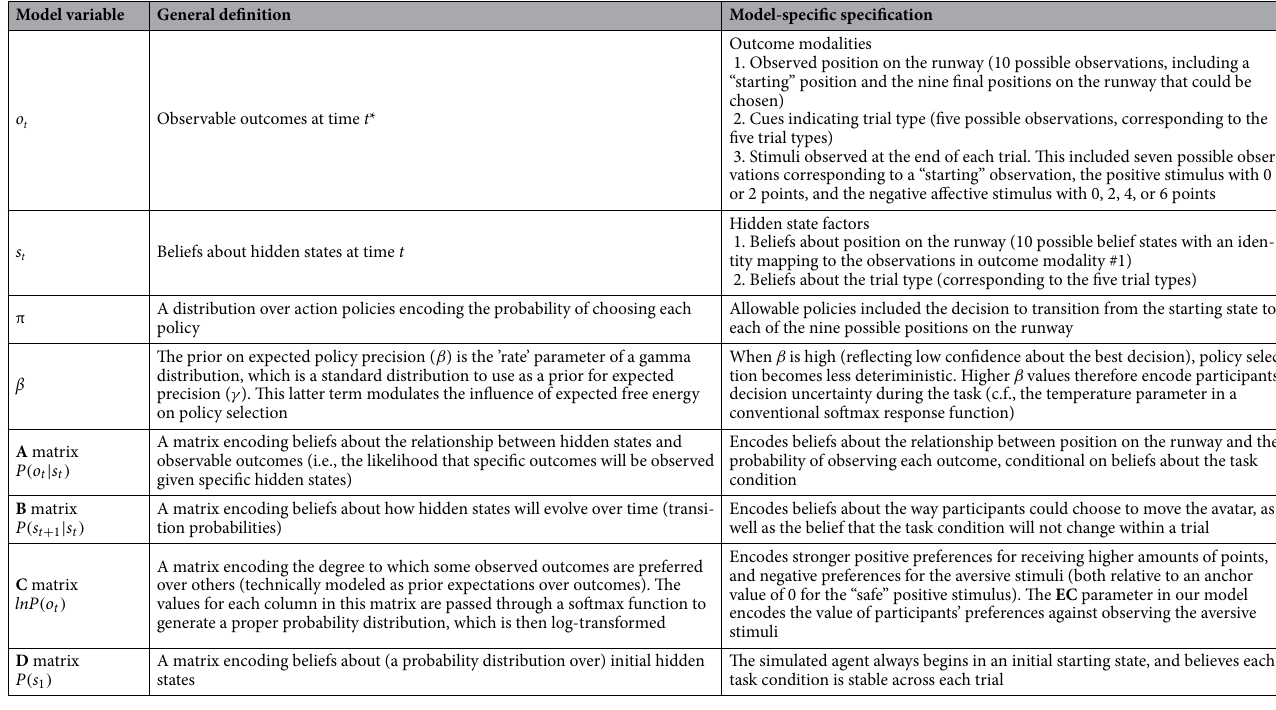
Table 2. Markov decision process model of the AAC task. *Note that t here refers to a timepoint in each trial about which participants have beliefs. Before a participant makes a choice (i.e., when still in the “start” state), they have prior beliefs about the state at time t = 2, and these beliefs are then updated after a subsequent observed outcome. In the active inference literature these beliefs about timepoints are often instead denoted with the Greek letter tau (τ) in order to distinguish them from the times ( t ) at which new observations are presented (for details, see 54